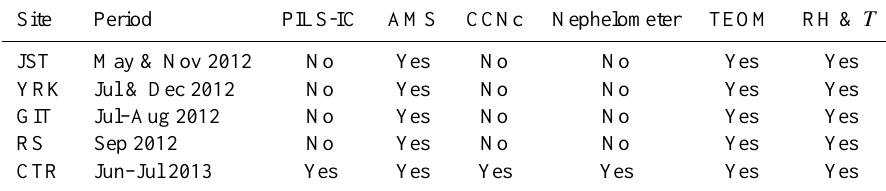
Table 1. Deployment status of instruments at various sites. All the listed instruments or probes were operated at CTR for SOAS. Site Period